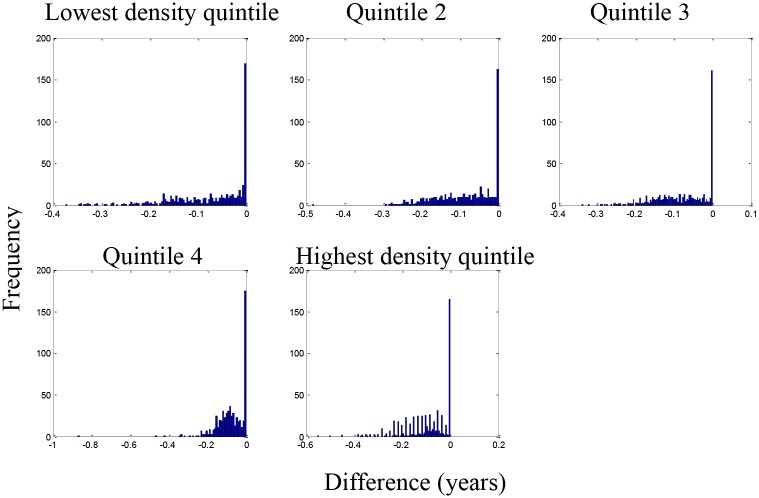
Change in life expectancy (years lost) resulting from being above the regional 25th percentile for each pollutant.